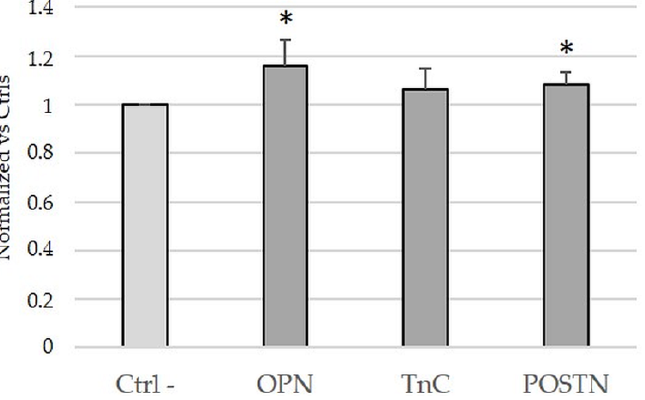
Figure 5. Cell viability of HuCCT-1 cells upon treatment with medium supplemented with OPN, TnC and POSTN. Twenty-four-hour treatment of HuCCT-1 cells with OPN and POSTN, but not with TnC, induced slight increase in cell viability; n = 4 to 6 in duplicate for each experiment. * p < 0.01 vs. controls (untreated) using one-way ANOVA